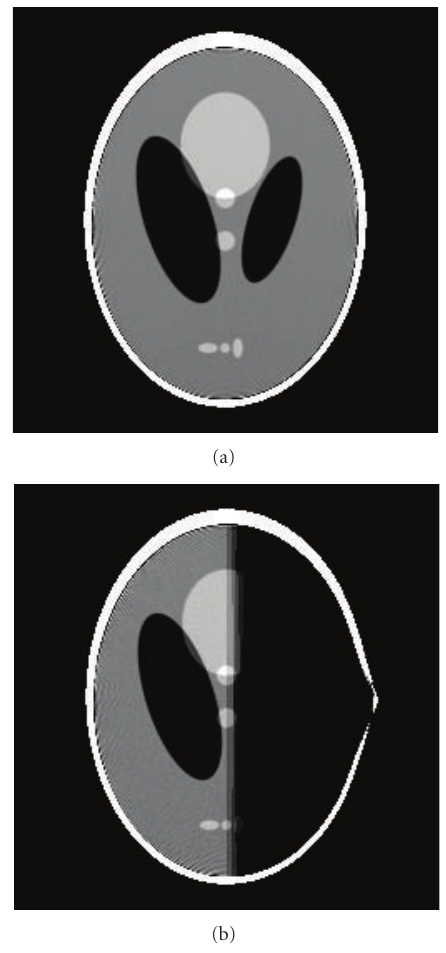
Figure 5: Reconstructed slices at z = − 0 . 25 of Shepp-Logan low- contrast phantom using HFDKW-1 formula for (a) short scan segment on a helical trajectory. (b) Less than short scan segment. The value of pitch used is 0 . 125m. Display window is [1 1 .